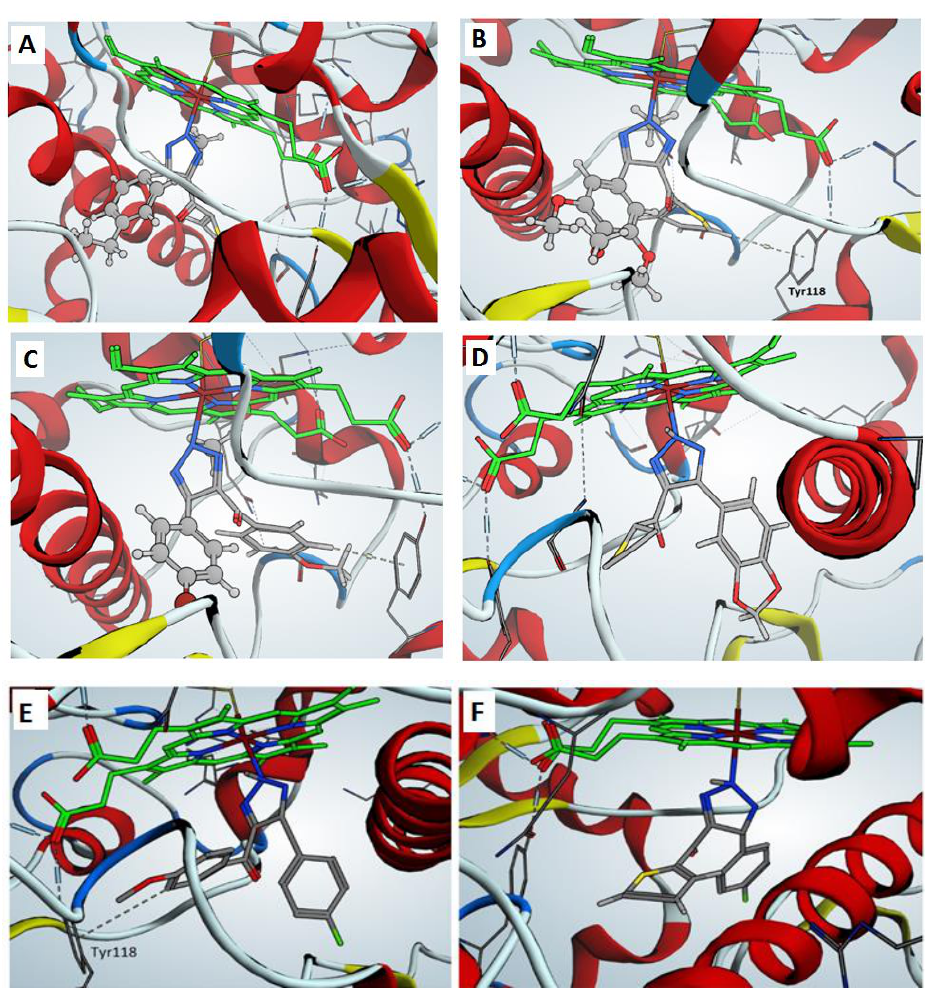
Figure 6. ( A ) Docking pose of the compound GKV10. ( B ) Docking pose of the compound GKV11. ( C ) Docking pose of the compound GKV15. ( D ) Docking pose of the compound GKV9. ( E ) Docking pose of the compound GKV7. ( F ) Docking pose of the compound GKV8.